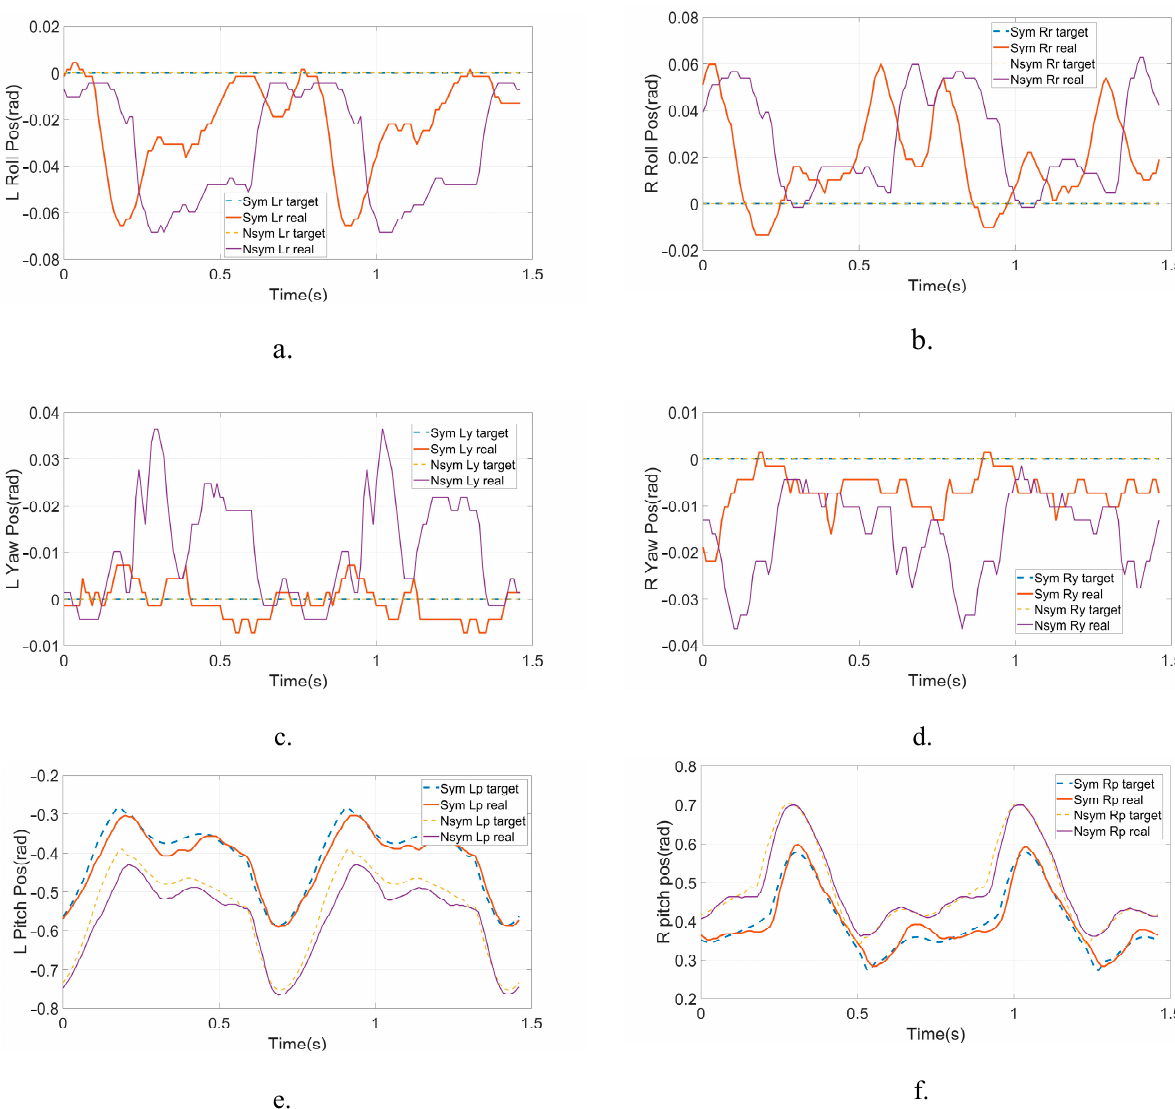
j. Figure 8. The positions and tracking performance of each active joint for two steps. ( a ) Left Hip Roll tracking performance. ( b ) Right Hip Roll tracking performance. ( c ) Left Hip Roll tracking perfor- mance. ( d ) Right Hip Roll tracking performance. ( e ) Left Hip Pitch tracking performance. ( f ) Right Hip Pitch tracking performance. ( g ) Left Knee tracking performance. ( h ) Left Knee tracking perfor- mance.( i ) Left Ankle tracking performance. ( j ) Right Ankle tracking performance. Figure 9. Five key frames of non-symmetrical walking experiment.